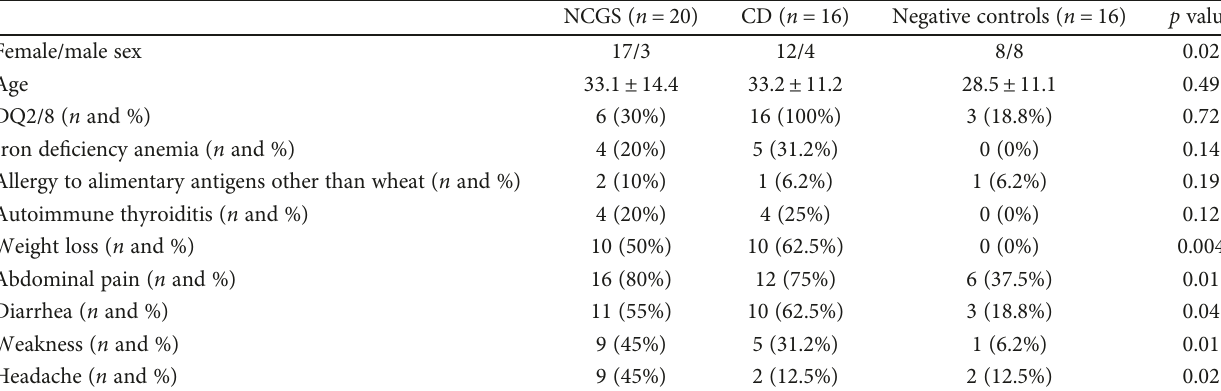
Table 1: Main demographic and clinical features of patients with nonceliac gluten sensitivity (NCGS), celiac disease (CD), and normal controls. The χ 2 for trend was employed for statistical